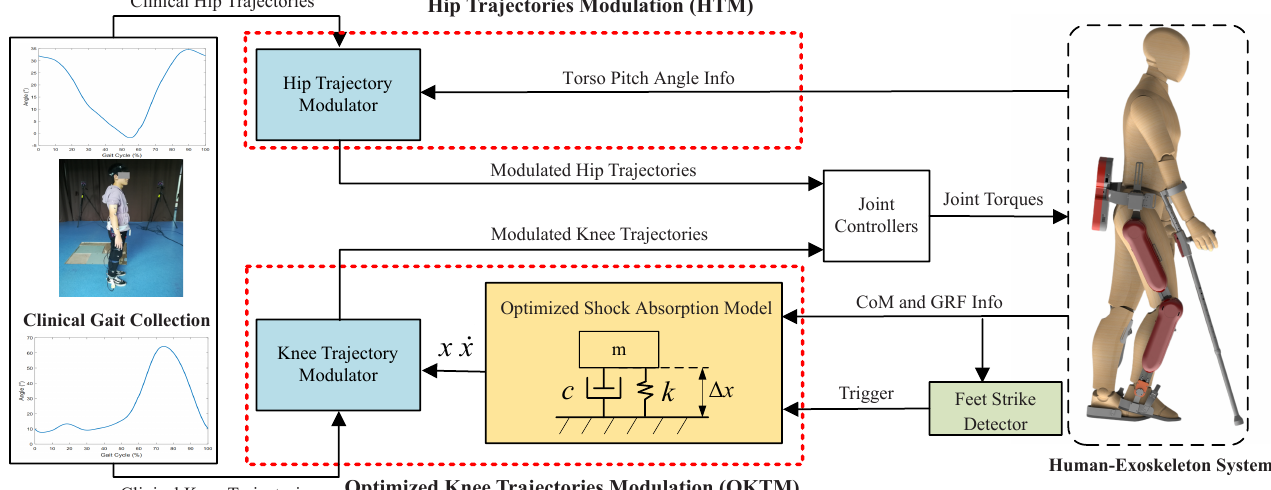
Figure 2. The framework of the proposed approach. The left part is a clinical gait collection by motion-capture systems, e.g., VICON, etc. The right part is a human-exoskeleton system. The proposed approach has two modulations: the OKTM and the HTM. The OKTM is composed of two parts: the OSAM and the knee-trajectory modulator. The OSAM is designed to generate the response of the spring-damping system. The knee-trajectory modulator can integrate clinical gait trajectories with the output of OSAM. In the second part, the HTM can modulate the clinical hip trajectories to stabilize the